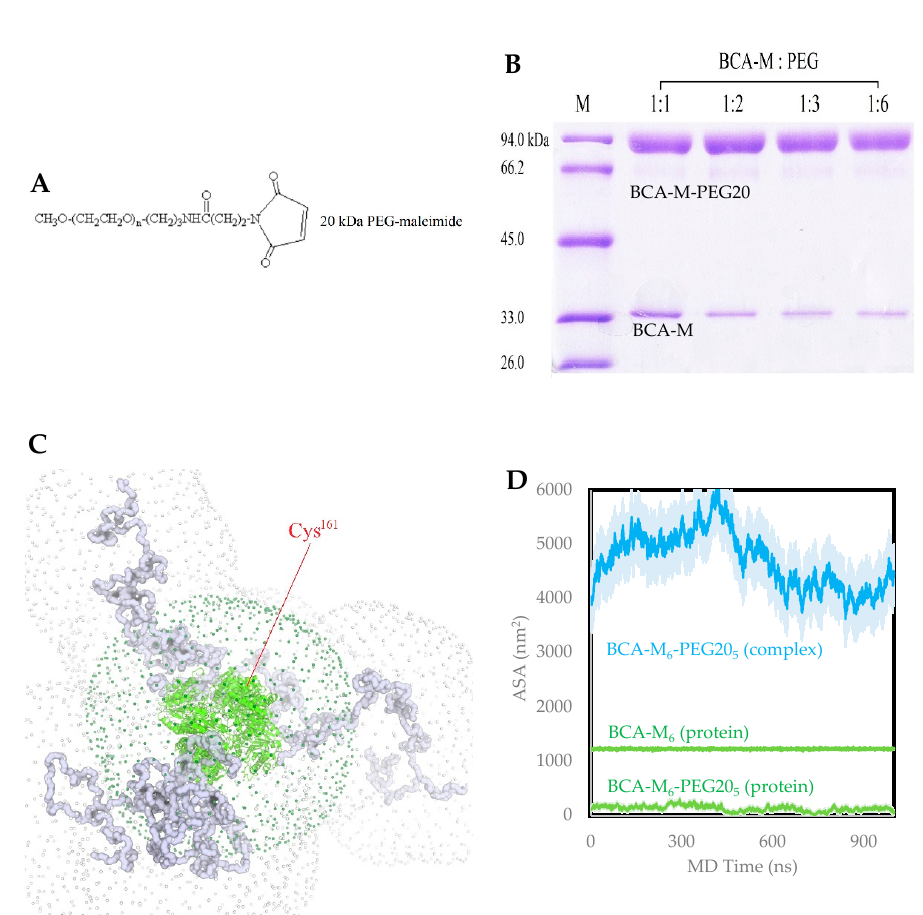
Figure 3. PEGylation optimization and molecular dynamics (MD) study of BCA-M. ( A ) The chemical structure of 20 kDa PEG-maleimide. ( B ) BCA-M was reacted with 1, 2, 3 and 6 molar equivalents of PEG 20 kDa. ( C ) Coarse-grained molecular dynamics snapshot: the BCA-M 6 is shown as green cartoon, with the PEG20 chains as grey tubes. The grey dotted surface depicts the solvent-accessible surface (SAS) of BCA-M 6 -PEG20 5 probed with a sphere of 4.9 nm radius. The dark green dotted surface is the SAS of the BCA-M 6 only. The only Cys 161 residue that does not have PEG20 attached is indicated. ( D ) The total accessible surface area (ASA) of BCA-M 6 (middle, green) and BCA-M 6 -PEG20 5 (cyan) are shown. The protein component of the total ASA of BCA-M 6 -PEG20 5 is the lower curve (green). The standard deviation throughout MD time was used as error bars.